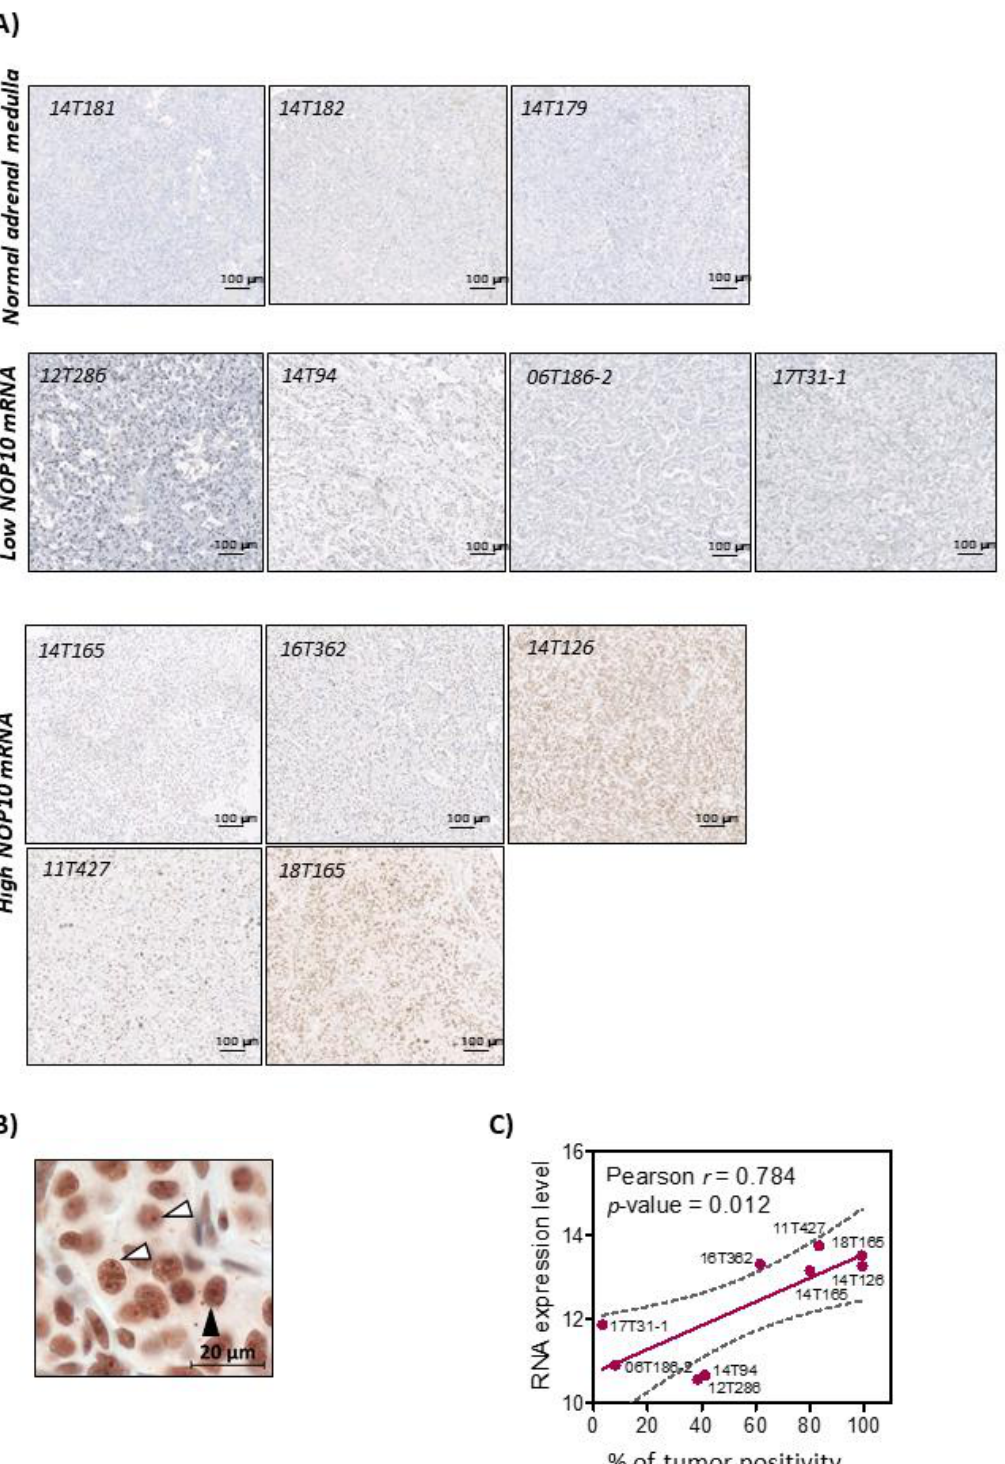
Figure 3. NOP10 immunohistochemistry. ( A ) Representative staining images of normal adrenal medulla ( n = 3), tumors with low NOP10 expression ( n = 4) and NOP10 overexpressing tumors ( n = 5). ( B ) Magnified image from an NOP10-positive staining (14T126). Black arrow: representative nuclear staining. White arrows: representative nucleolar staining. ( C ) Linear regression plot of NOP10 RNA expression and percentage of tumor positivity. Pearson correlation r and p -value are